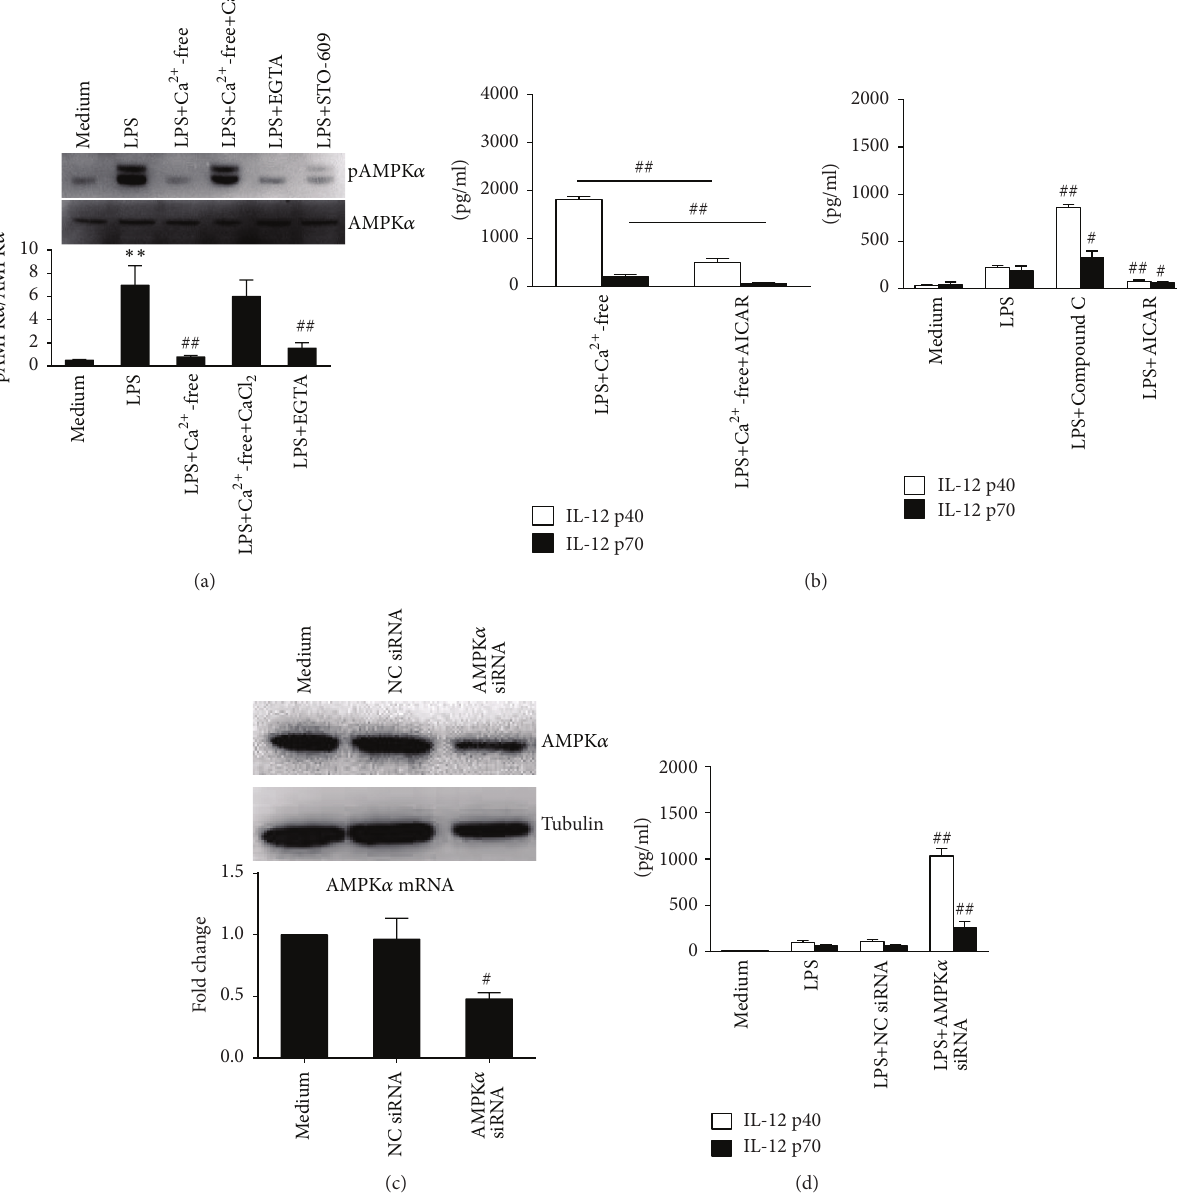
AMPK 𝛼 phosphorylation. We further treated RAW